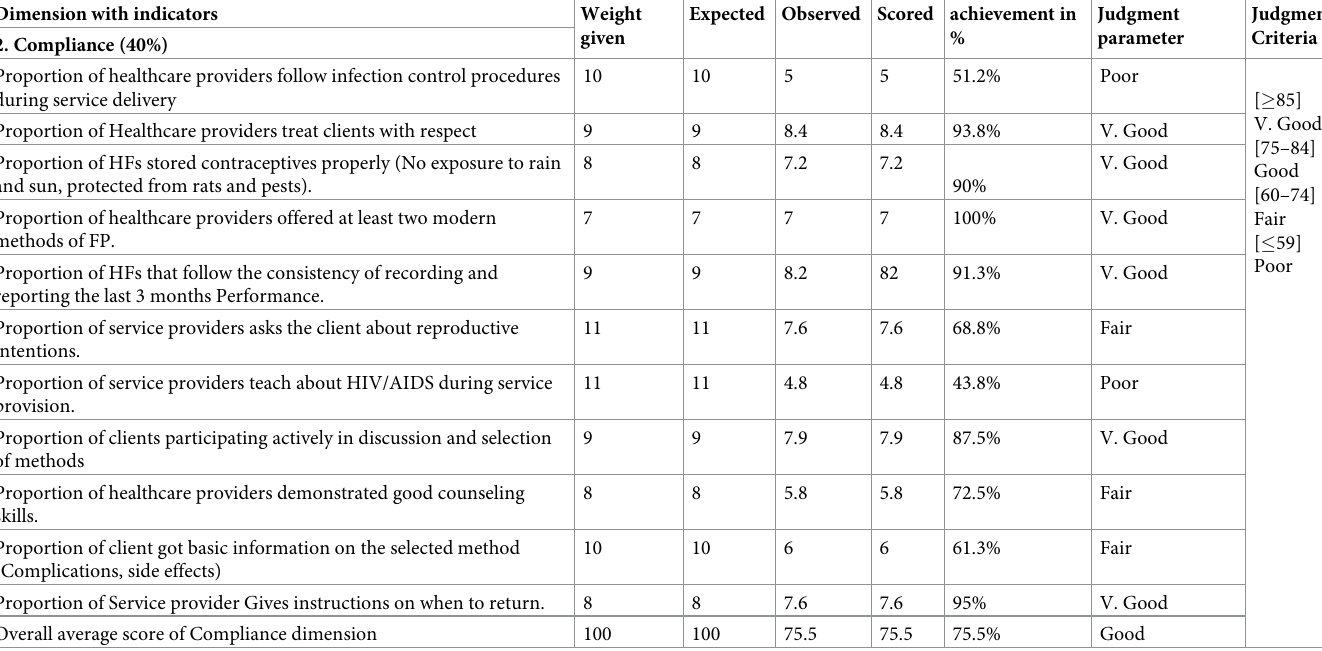
Table 3. Judgment Matrix of Compliance dimension of family planning service in Gondar city administrative public health facilities, Northwest Ethiopia, 2020. Dimension with indicators Weight